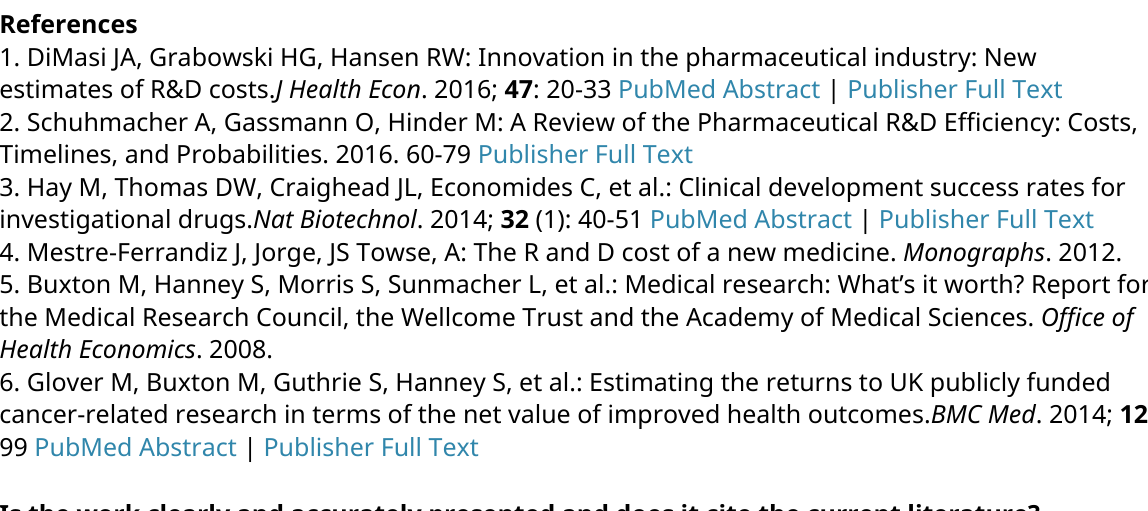
One typo spotted in the heading for table 11 (page 22): a space is needed between number 18 and